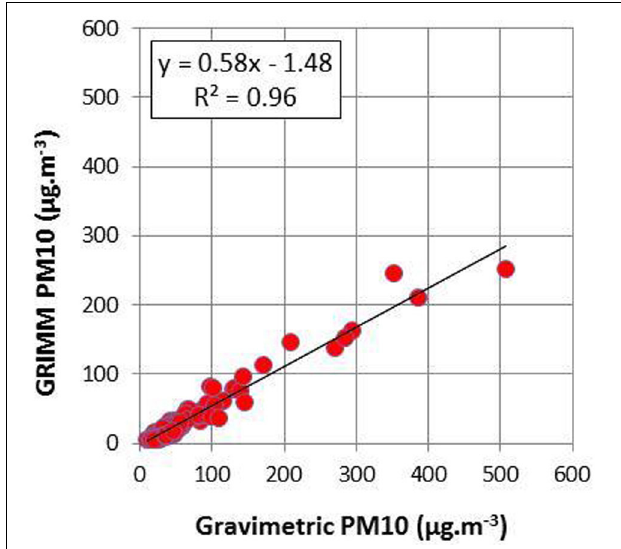
FIGURE 2 | Comparison between PM 10 concentrations measured in parallel with the GRIMM and with the gravimetric method. The best fit regression line and the respective equation and correlation coefficient are given in the figure.